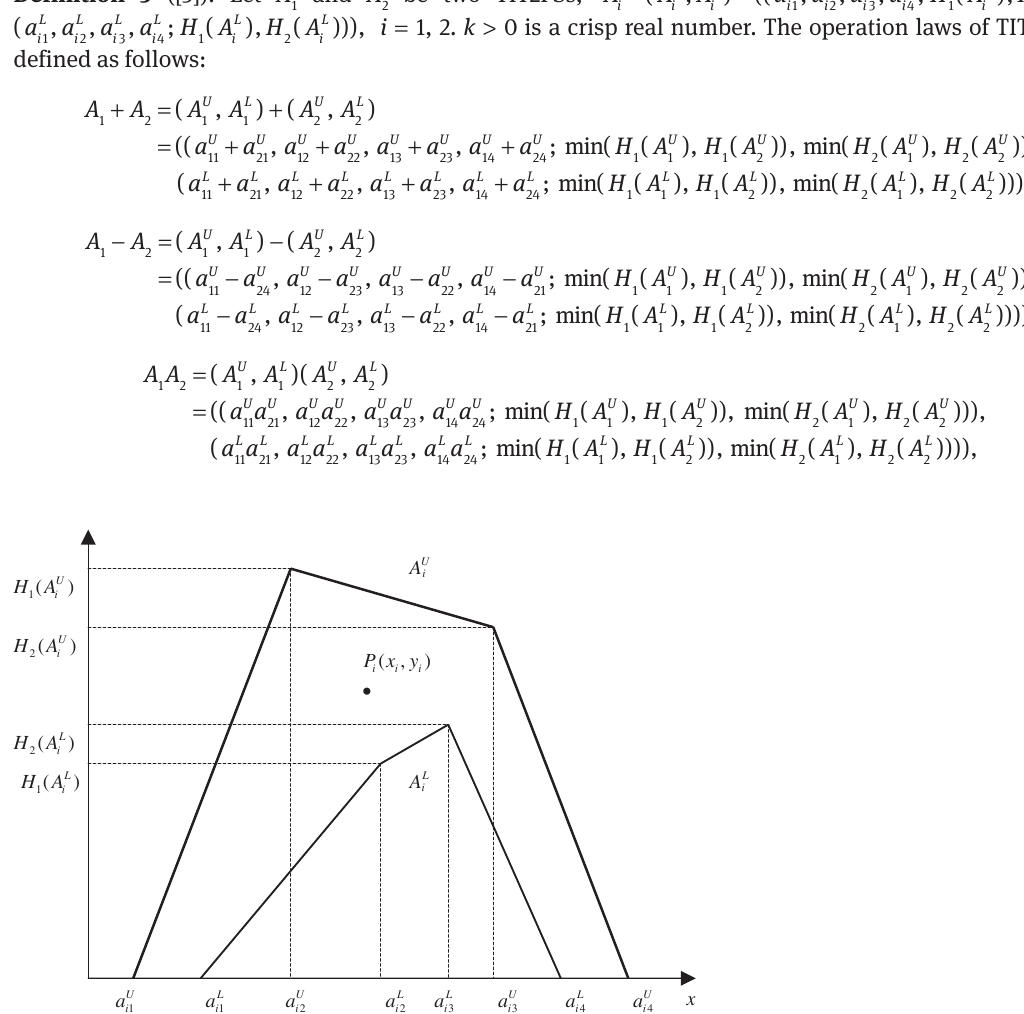
Figure 1. The Upper Trapezoidal Membership Function U